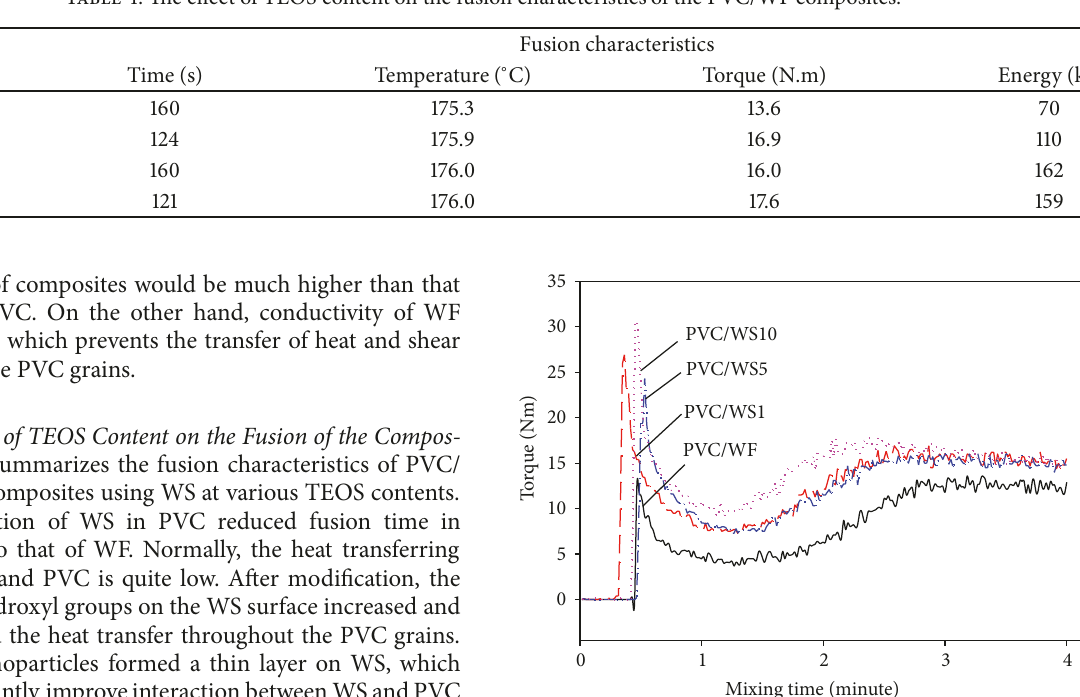
Figure 7: Schematic of torque - mixing time of (a) the neat PVC and (b) PVC/WF composites with various contents of WF (20, 30, and 40 wt%). Table 4: The effect of TEOS content on the fusion characteristics of the PVC/WF composites.